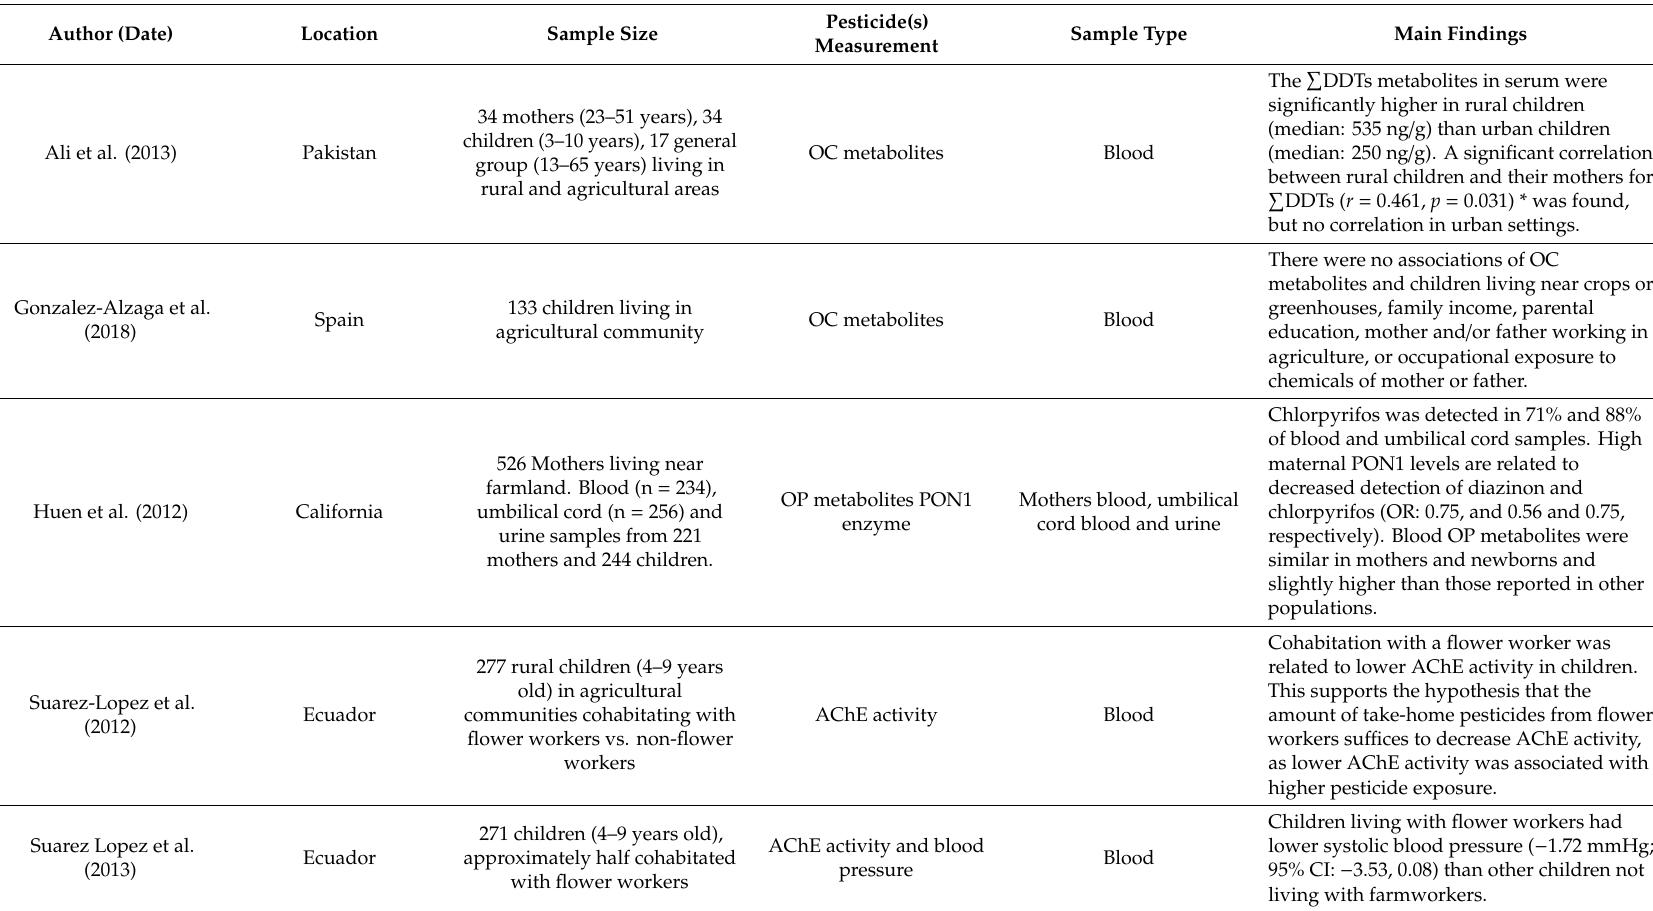
Table 1. Literature review summary on take-home pathway of pesticide exposure - blood